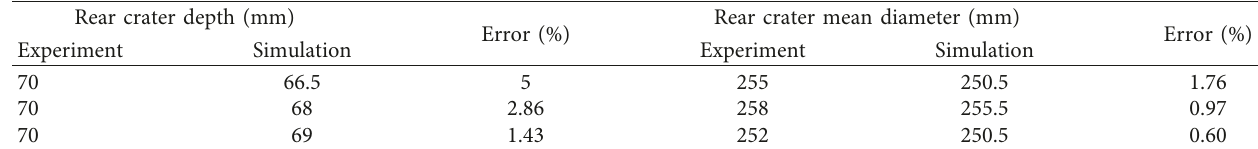
Figure 9: Comparison of experimental [29] and simulated results for the target damage (1/3): (a) front surface of target (3-0-334); (b) rear surface of target (3-0-334). Comparison of experimental [29] and simulated results for the target damage (3/3): (c) front surface of target (2- 1-431); (d) rear surface of target (2-1-431); (e) front surface of target (1-2-331); (f) rear surface of target (1-2-331). Comparison of ex- perimental [29] and simulated results for the target damage (2/3): (g) front surface of target (0-3-317); (h) rear surface of target (0-3-317). Table 3: Comparison of experimental [29] and simulated results for the rear crater damage (3-0-334).